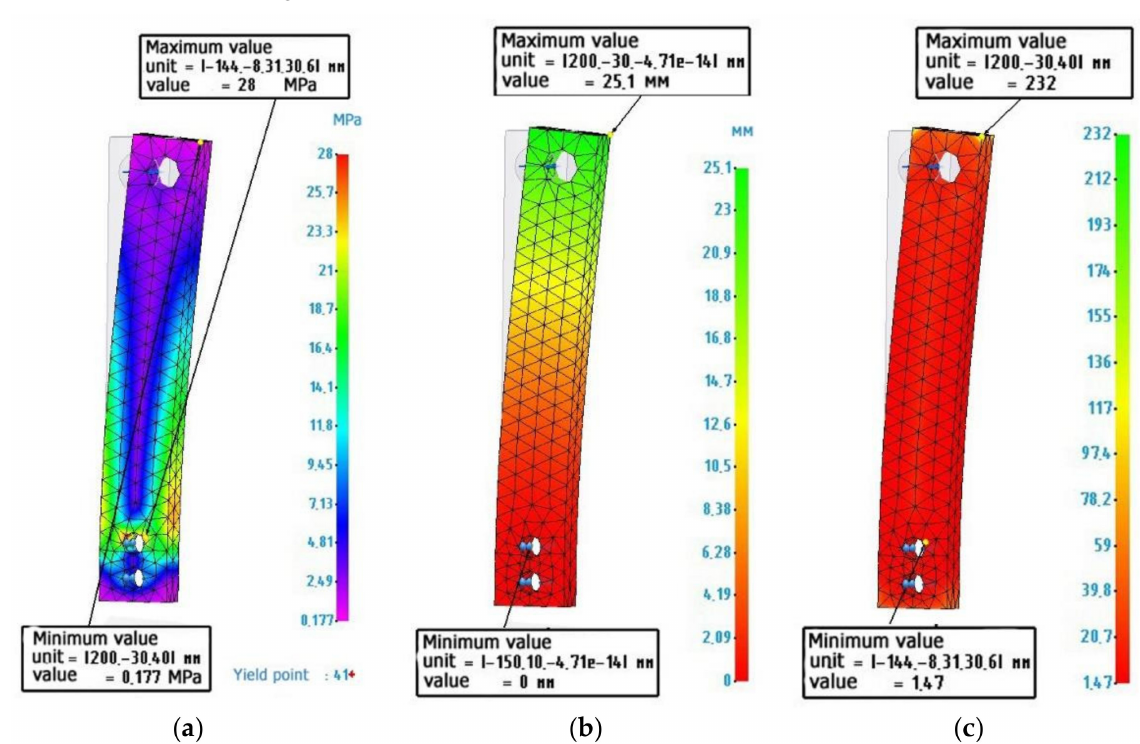
Figure 8. Finite element analysis of an ABS plastic sample: ( a ) Stress diagram according to von Mises, maximum value 28 MPa; ( b ) Strain diagram, maximum value 25.1 mm: ( c ) Safety factor diagram, minimum value